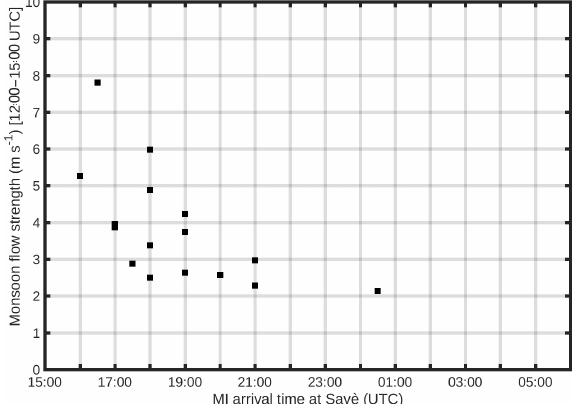
Figure 7. Scatter plot of the average monsoon strength between 12:00 and 15:00UTC and the MI arrival time using FLF mean = 1, for the time period between 1 and 30 July